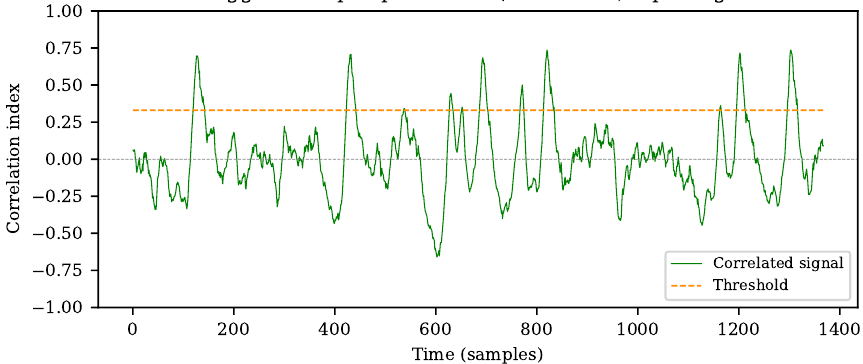
Figure 4. Threshold over pre-processed (correlated) signal trace